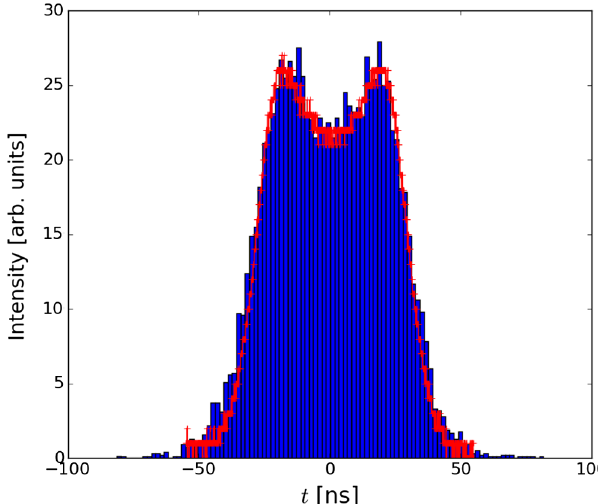
FIG. 8. Comparison of the experimentally measured final distribution of Fig. 7 (red trace) to the simulations (blue histogram) performed with the parameters used in the experi- ment. The intensity of the simulated distribution is an adjustable parameter.